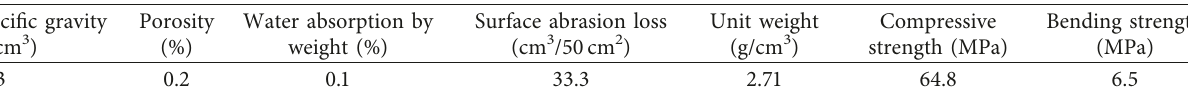
Table 8: Physical and mechanical properties of